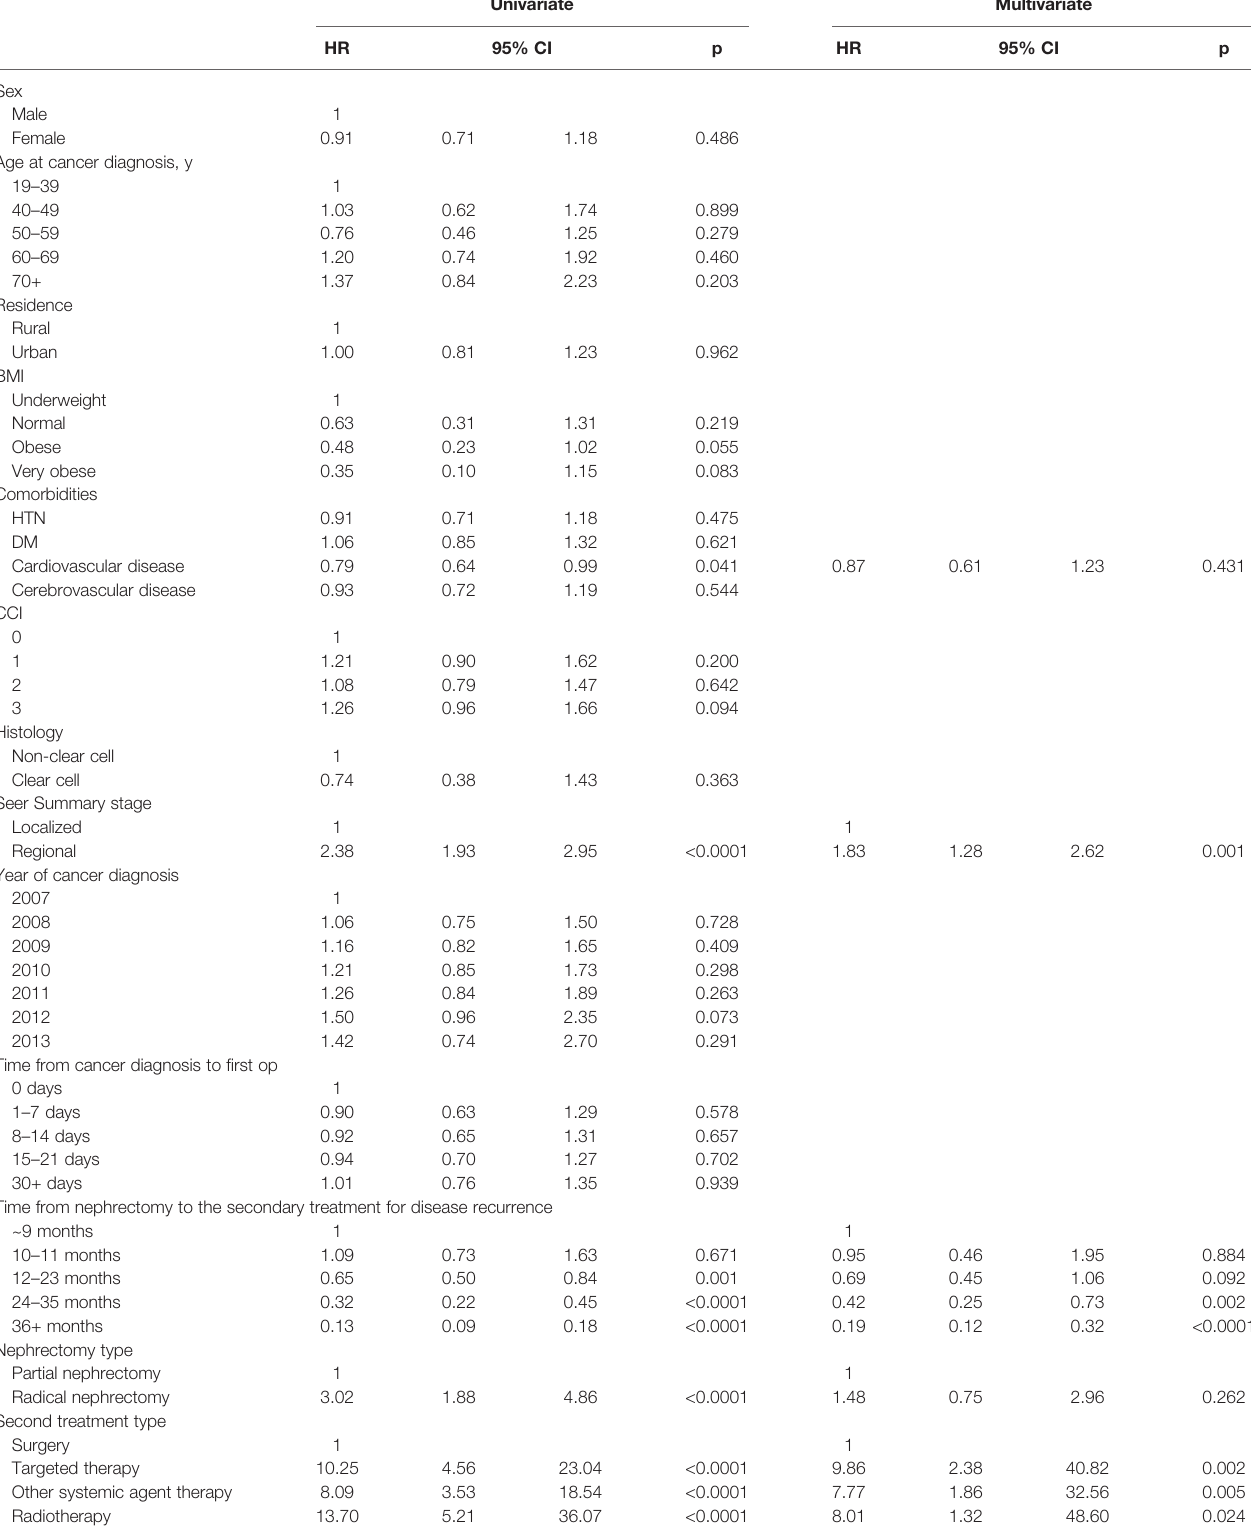
TABLE 4 | Multivariate analysis of RCC speci fi c survival in RCC patients with postoperative disease progression after nephrectomy. Univariate